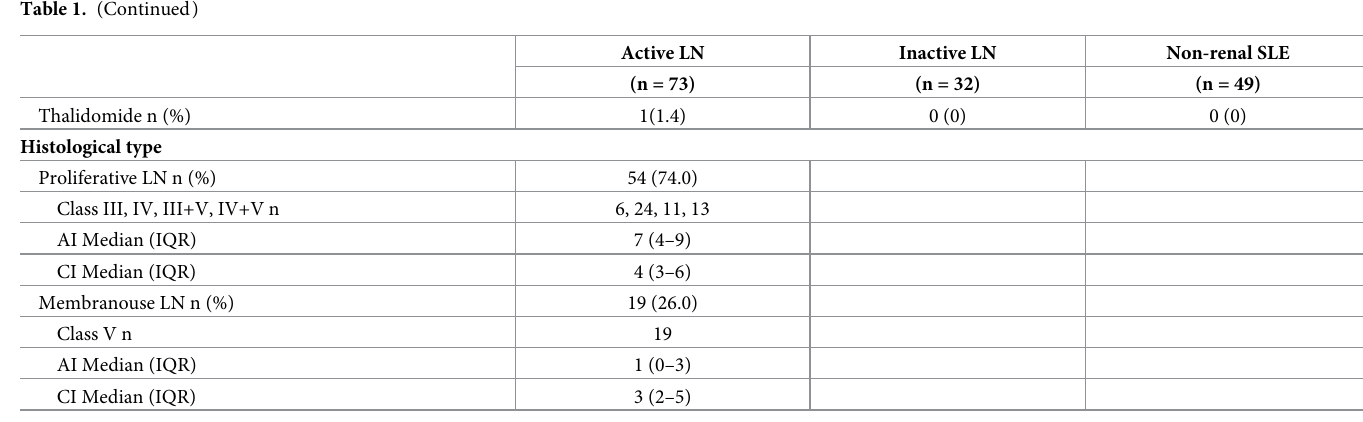
analysis was performed using Spearman’s rank correlation. Receiver operating characteristic (ROC) curve analysis was employed to evaluate the diagnostic value of various biomarkers in differentiating active LN from inactive LN. The area under the curve (AUC) was calculated and the best trade-off point of sensitivity and specificity was determined from the values calcu- lated for each of the coordinates on the curve. A two-tailed value of p < 0.05 was considered as statistically